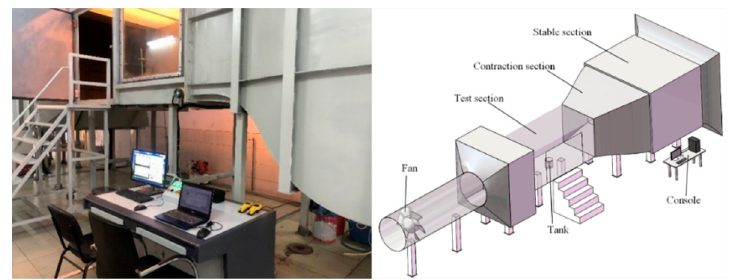
Figure 1. Wind tunnel for the experiment and simulation.